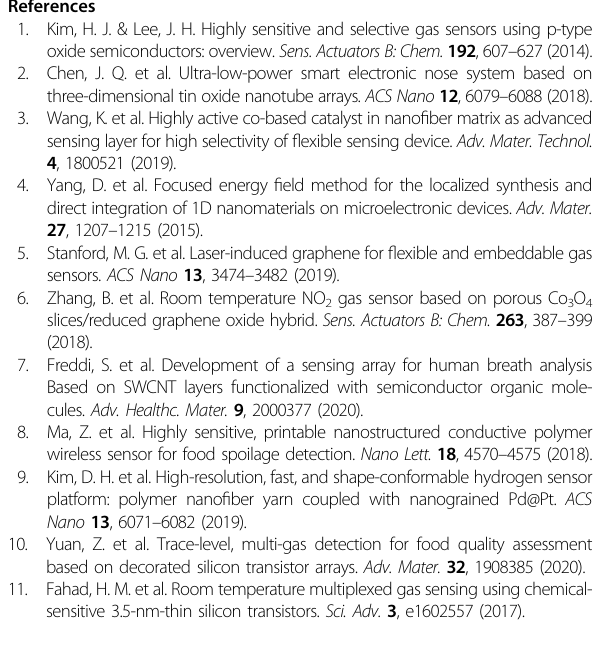
Fig. S8. For the best training results, hyperparameters of D-CNN learning was tuned, such as the size of the net- work, activation/loss functions, the learning rate for Adam optimizer, and weightings for classi fi cation and regression losses.